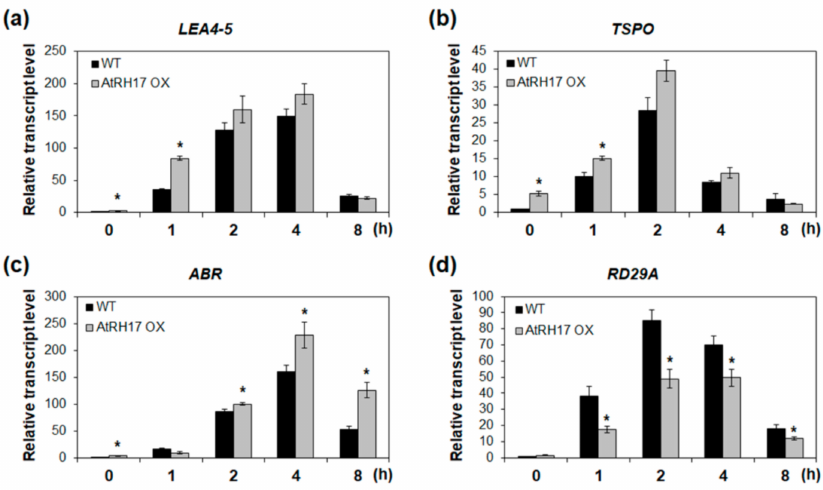
Figure 7. Expression analysis of three stress-responsive genes in AtRH17 OXs under salt stress conditions. Quantitative RT-PCR analysis of LEA4-5 ( a ), TSPO ( b ), ABR ( c ), and RD29A ( d ) in WT and AtRH17 OX seedlings under 150 mM NaCl treatment for 0, 1, 2, 4, and 8 h. GAPc was used as an internal control. Transcript levels at 0 h in WT were set as 1. Three independent reactions were performed for each technical replicate. Two technical replicates were performed for each biological replicate. At least two biological replicates showed similar results, with one shown here. Error bars represent standard deviation ( n = 6 reactions) and * indicates t-test * p < 0.05.